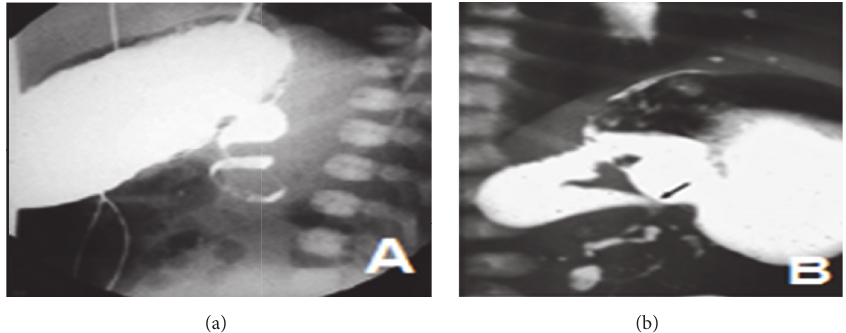
Figure 2: (a) Upper GI series shows the “corkscrew sign” in a frontal view. (b) Upper GI series shows malrotation with midgut volvulus. An incomplete duodenal obstruction and dilation of the first and second portions are seen, as is the “corkscrew sign.”